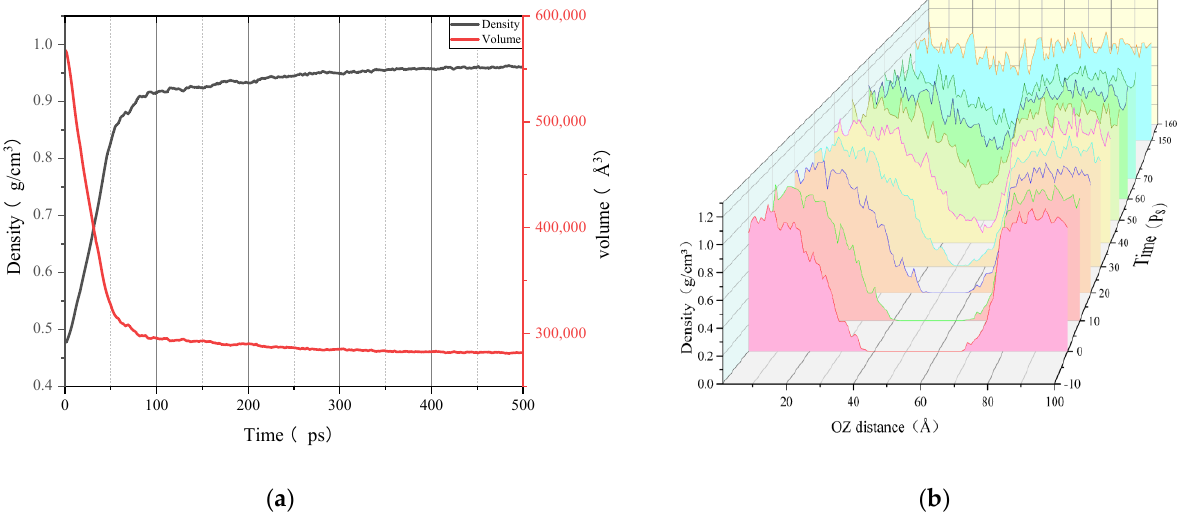
Figure 11. Density and volume change curves during healing process and density distribution curves under different time conditions: ( a ) variation of density and volume with self-healing time; ( b ) density distribution curves under different time